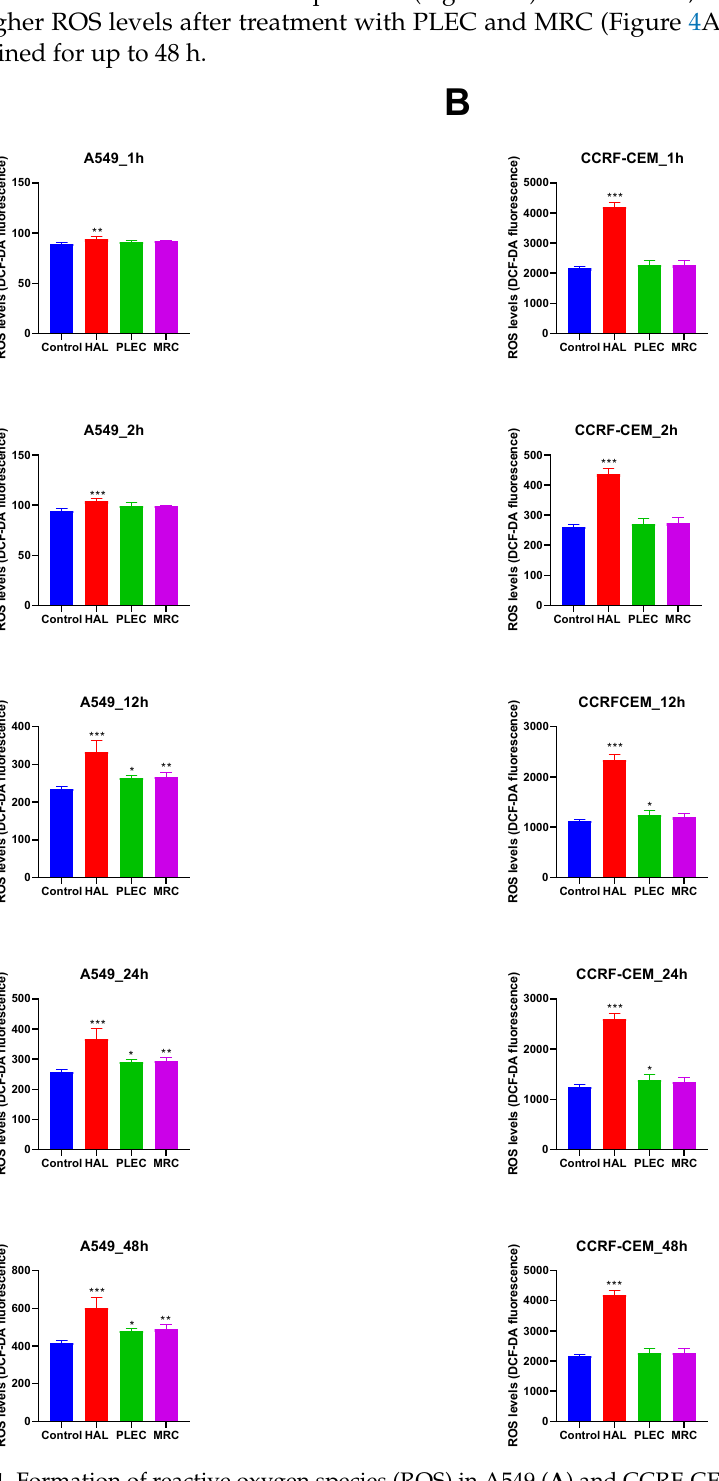
Figure 4. Formation of reactive oxygen species (ROS) in A549 ( A ) and CCRF-CEM ( B ) cells treated with HAL, PLEC and MRC for 1, 2, 12, 24 and 48 h. The results represent means ± SD. * p < 0.05, ** p < 0.01, *** p < 0.001 vs. control